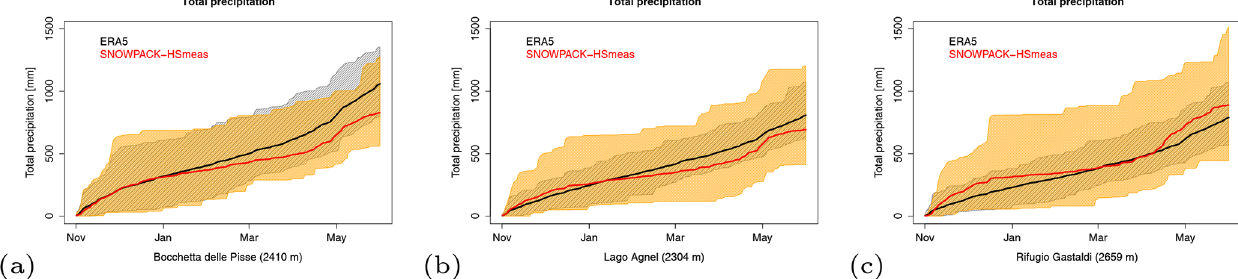
Figure 14. November–May accumulated total precipitation as estimated by (black) the ERA5 reanalysis and (red) the SNOWPACK model driven by the ERA5 forcing (all variables except for total precipitation) and the measured snow depth (HSmeas), for all three